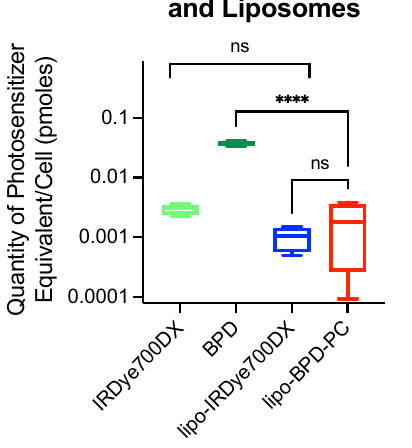
Figure 6: Comparison of FaDu cell uptake of lipo-IRDye700DX and lipo-BPD-PC, as well as free IRDye700DX and free BPD after 24 h incubation. (Data are mean ± standard error; statistical signi fi cance was calculated using one-way ANOVA with a Tukey post-test, ****: P ≤